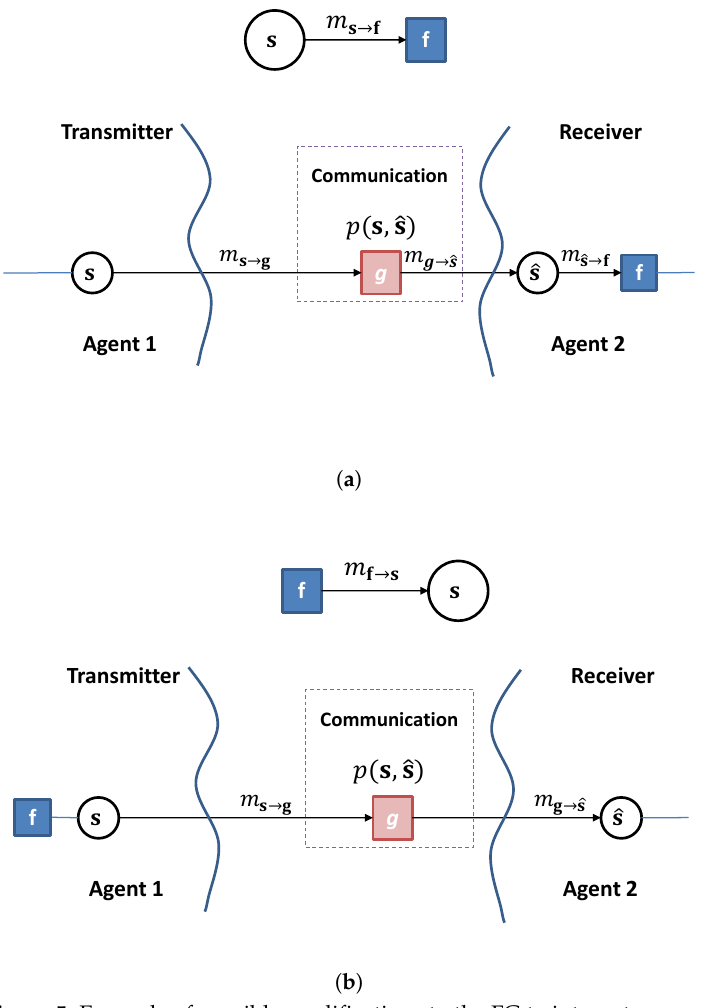
Figure 5. Example of possible modifications to the FG to integrate communication as a factor node between Agent 1 and Agent 2. ( a ) FG for transmitting the message m s → f from Agent 1 to Agent 2. ( b ) FG for transmitting the message m f → s from Agent 1 to Agent